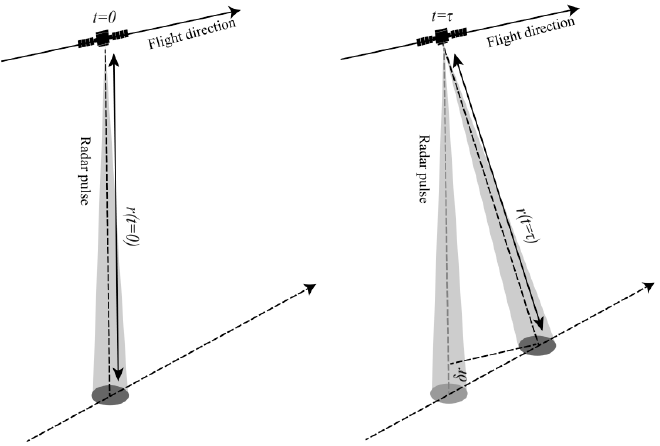
Figure 1. The schematic diagram of real-aperture radar